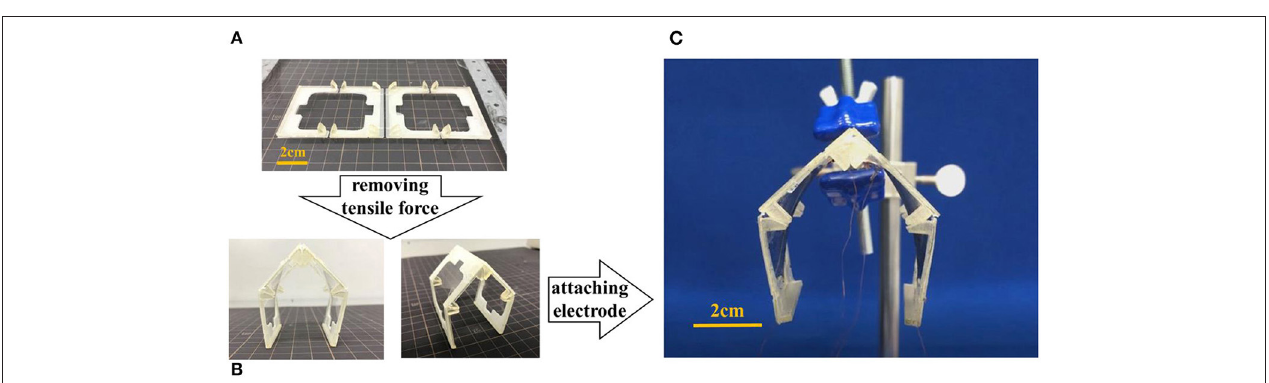
FIGURE 16 | Blueprint of the gripper and appearance of frames A 1 and A 2 .